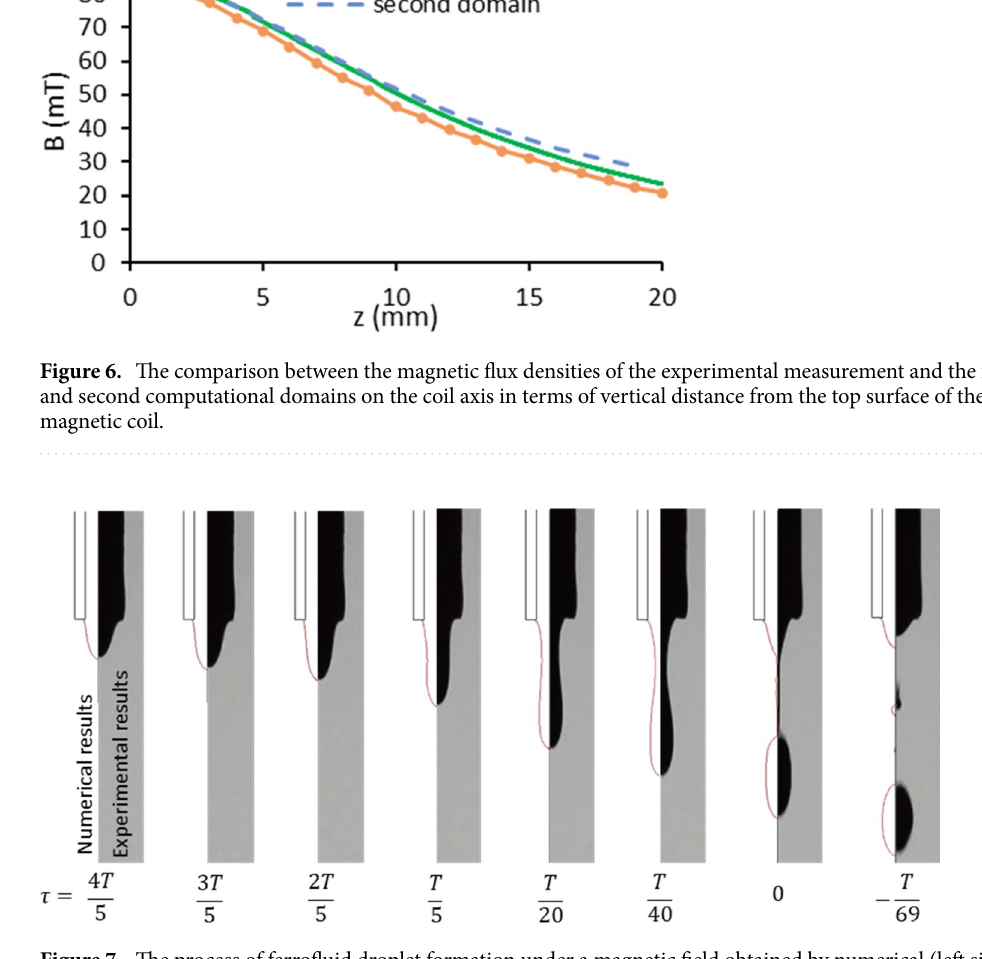
t breakup t represents the remaining = −